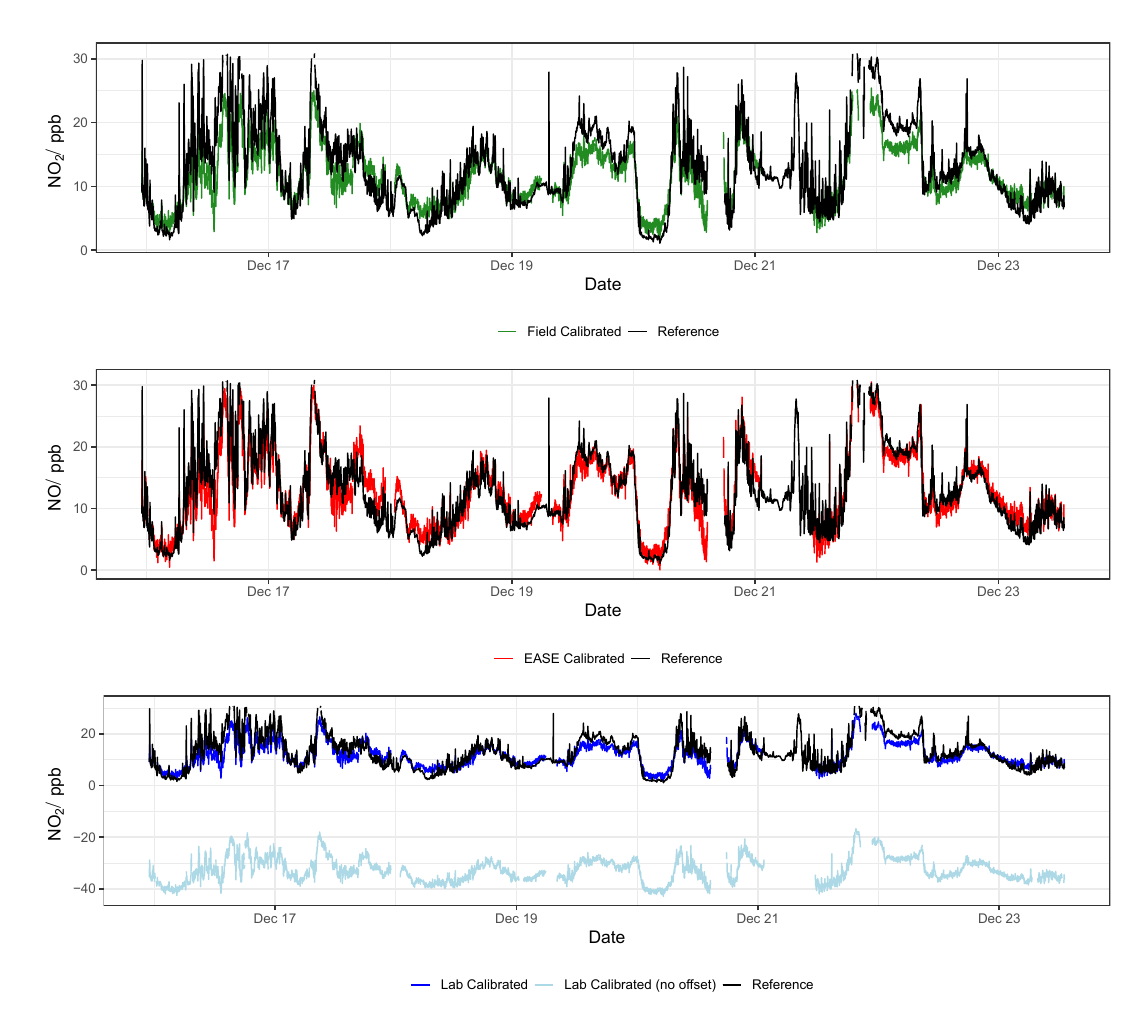
Figure 15. Example NO 2 time-series from a single EC node during the validation of the different calibration methods, compared with data from the reference instrument. Lab is short for